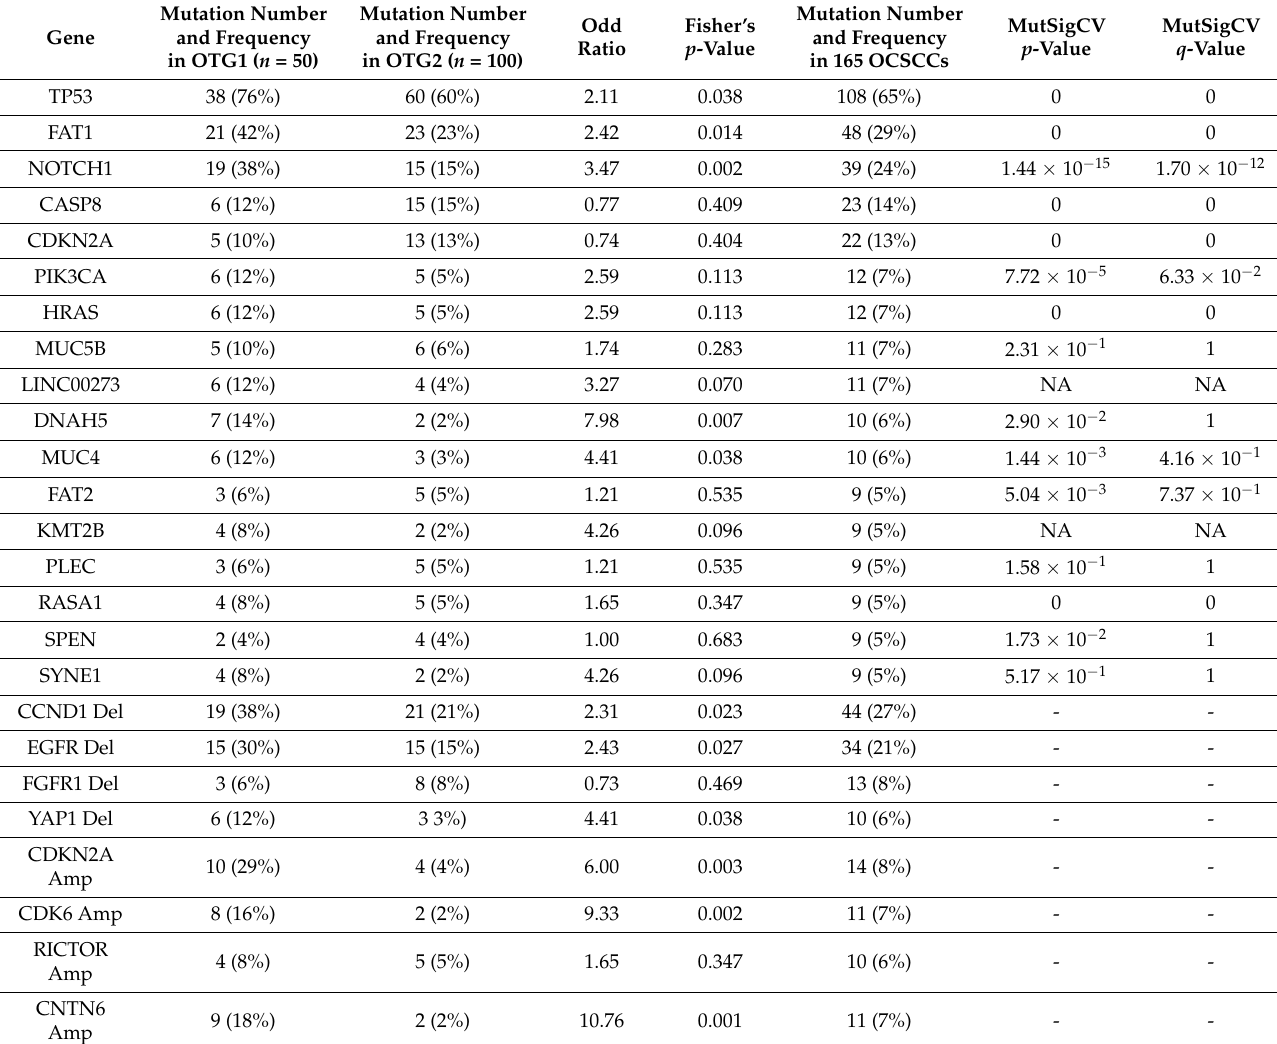
Table 1. Frequently mutated genes in oral cavity squamous cell carcinoma. Del indicates a deletion present in the gene being transcribed. Amp indicates an amplification in the